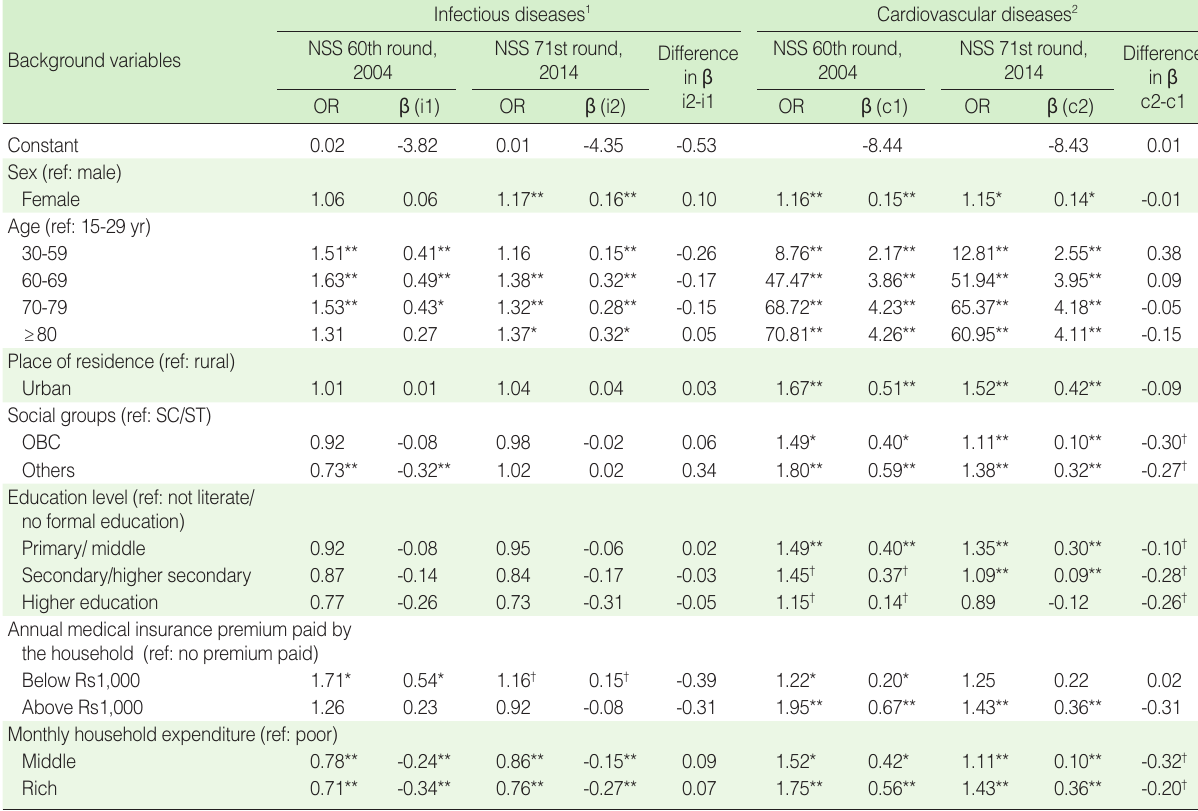
Table 4. Results of logistic regression for prevalence of infectious diseases and cardiovascular diseases in India, 2004 and 2014